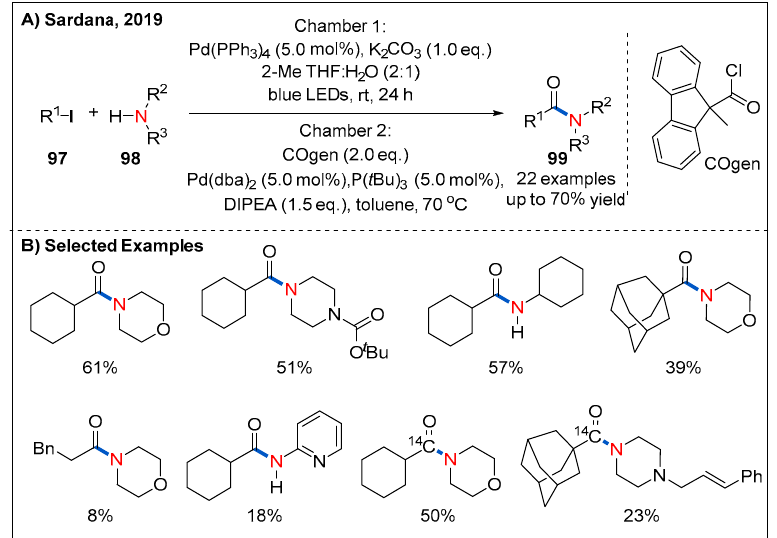
Figure 30. Amide synthesis via photoinduced palladium-catalyzed aminocarbonylation.